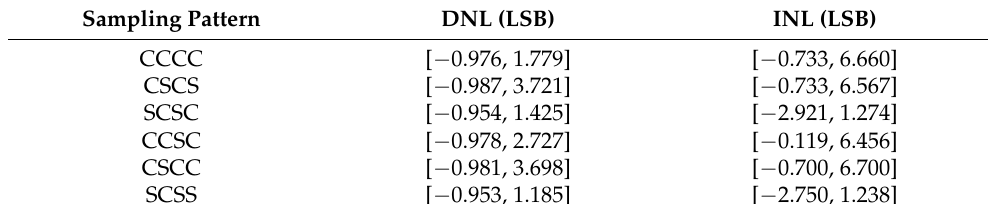
Table 2. Sampling patterns comparison.